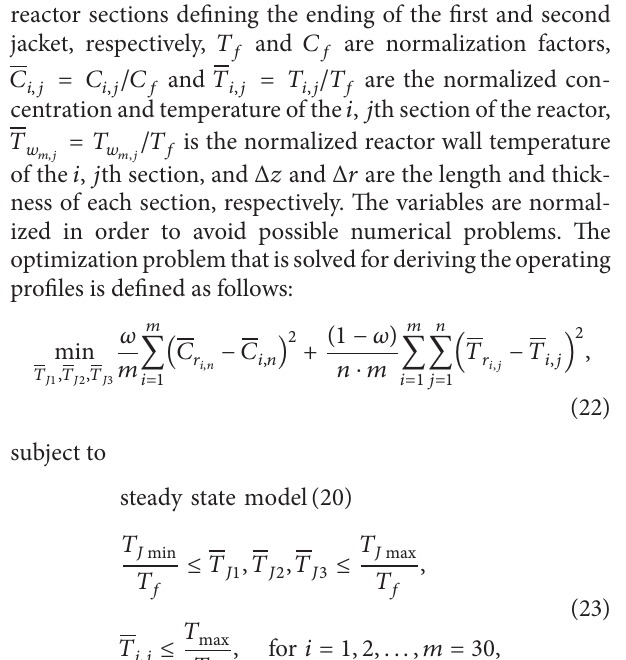
The algorithm was executed using different initial condi- tions. Along the experiments, one local minima was